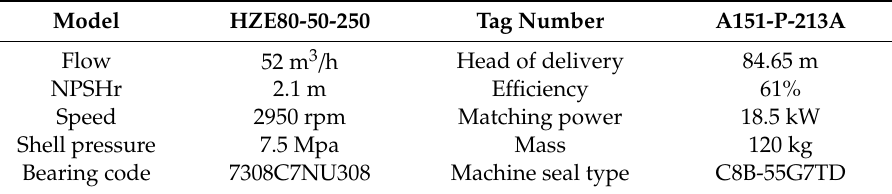
Table 1. Parameters of the centrifugal water pump used in this experiment.